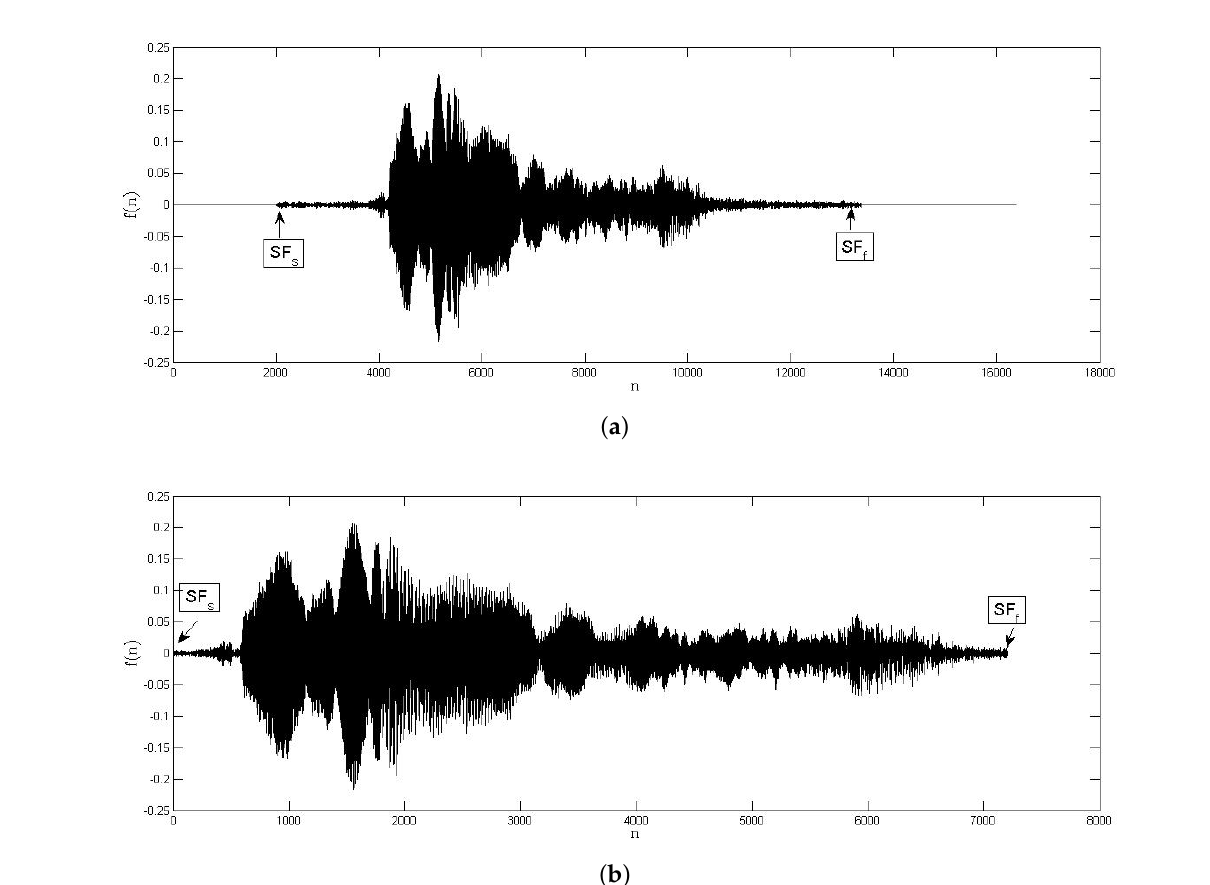
Figure 2. Bird vocalization automatic identification: audio record of a bird vocalization ( a ) before and ( b ) after automatic region